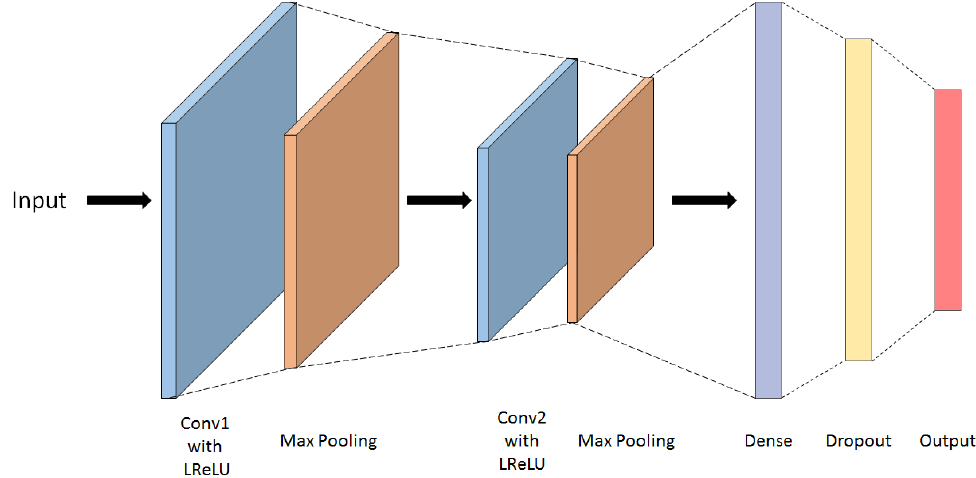
Figure 7. Architecture of the CNN framework